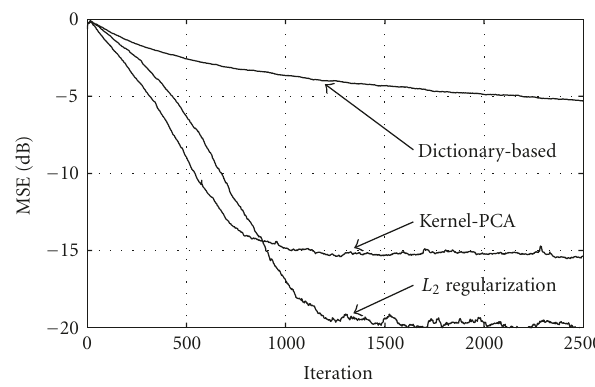
Figure 11: Wiener system MSE e 2 tification of a Wiener system that exhibits an abrupt change and contains additive noise.